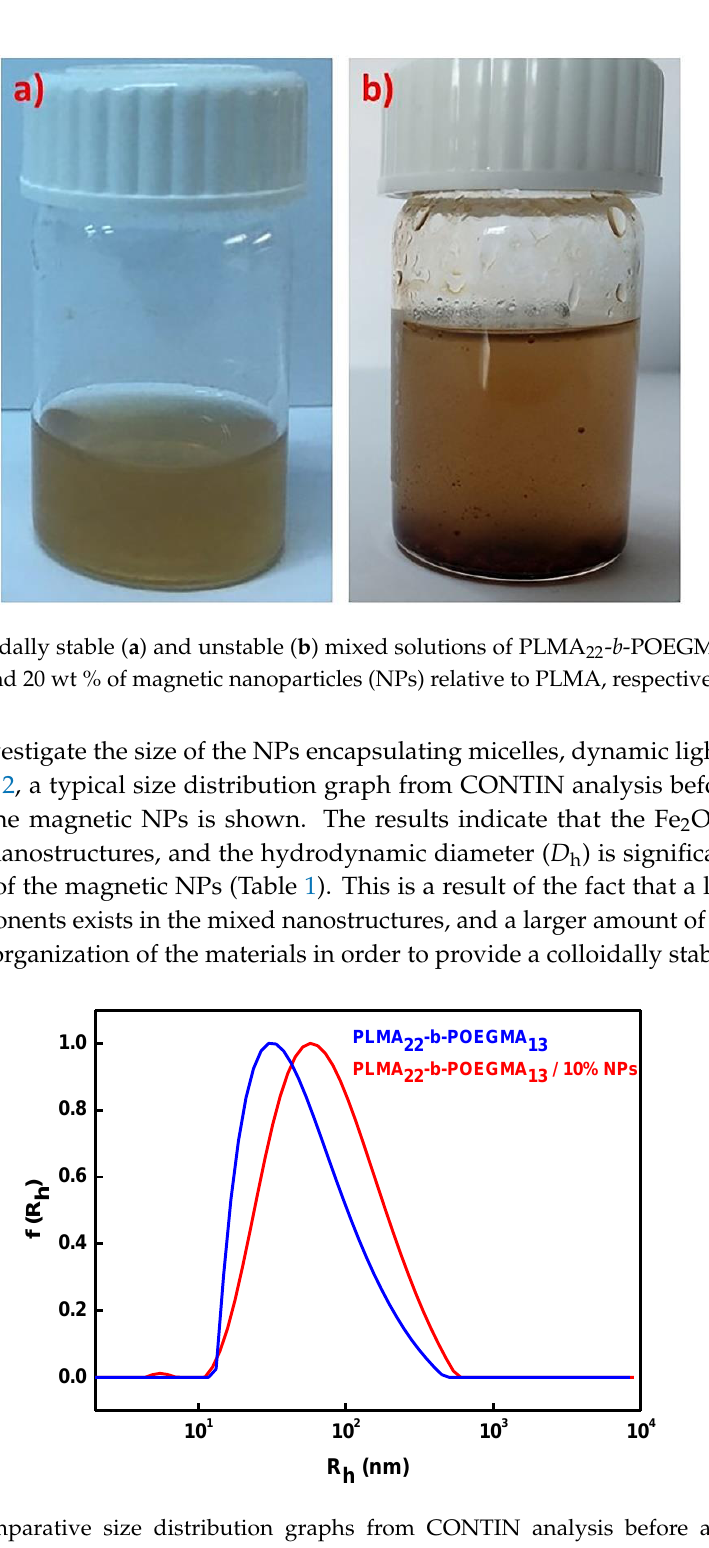
Figure 2. Comparative size distribution graphs from CONTIN analysis before and after the encapsulation of the magnetic NPs within the PLMA 22 -b-POEGMA 13 micelles.